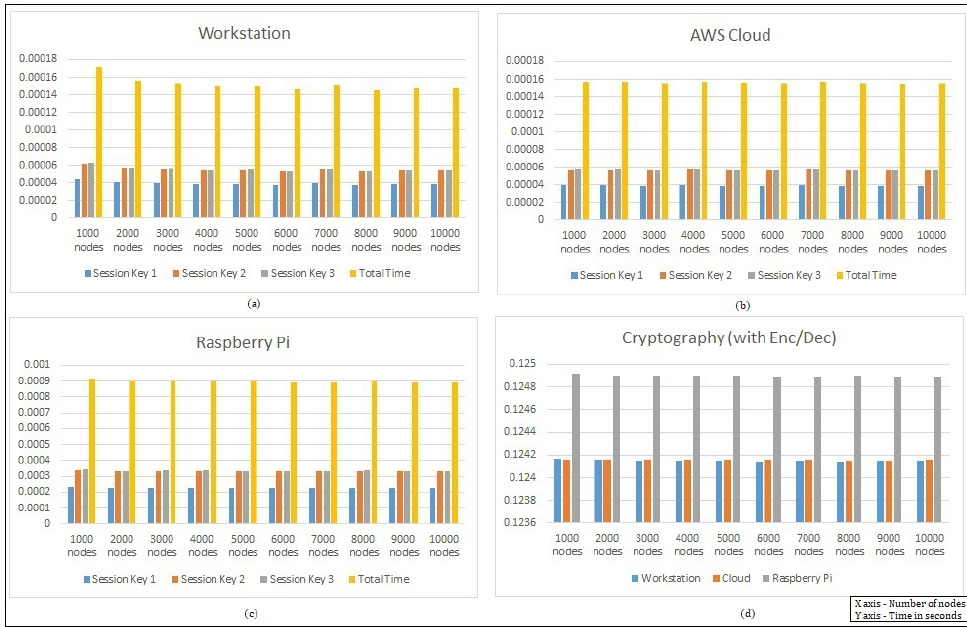
Figure 7. Performance with respect to the hash-chain fog/edge protocol total time on the ( a ) worksta- tion, ( b ) AWS Cloud, and ( c ) Raspberry Pi and ( d ) for message exchange with